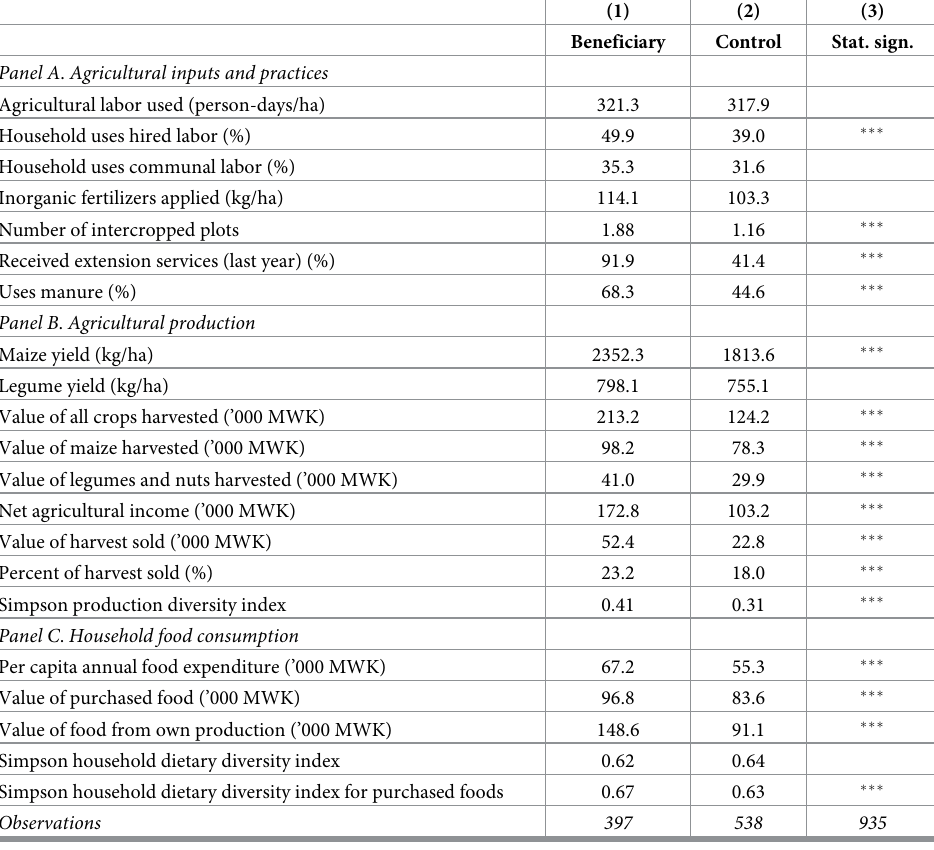
Table 2. Descriptive summary of agricultural and dietary outcomes by beneficiary status.